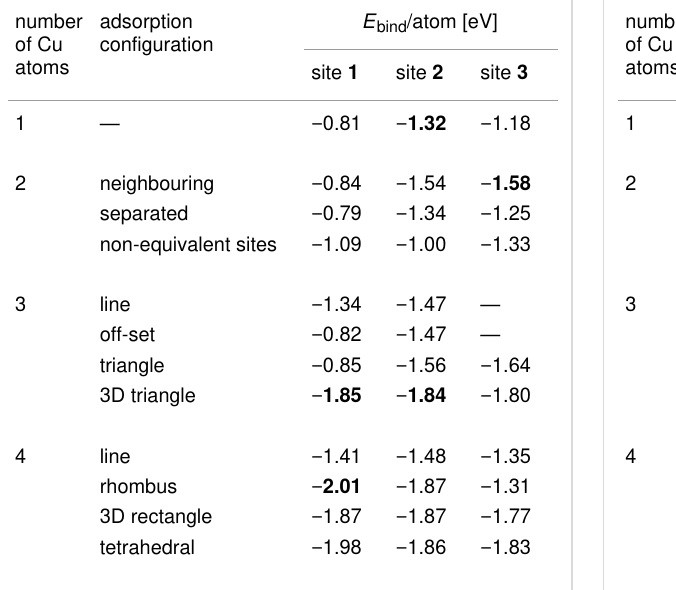
Table 1: Computed binding energies for Cu 1 , Cu 2 , Cu 3 and Cu 4 on a MoS 2 ML for different atom configurations using Equation 1. For the “non-equivalent” configurations of Cu 2 , the column “site 1 ” has atoms at sites 1 and 2 , “site 2 ” has atoms at 1 and 3 and “site 3 ” has atoms at 2 and 3 .